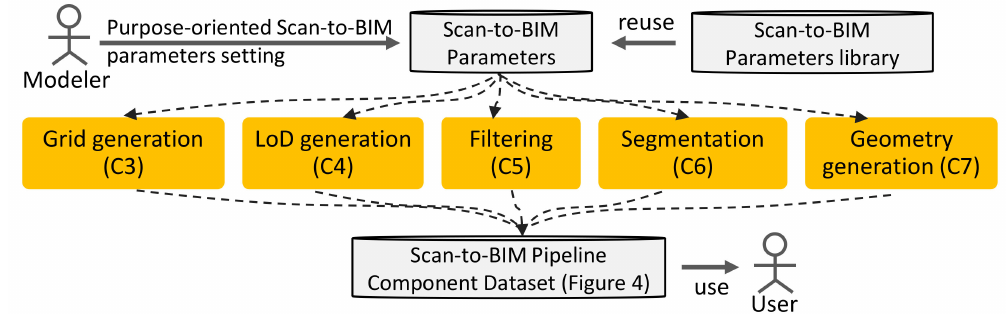
Figure 5. Purpose-oriented Scan-to-BIM Parameters Setting related to Pipeline